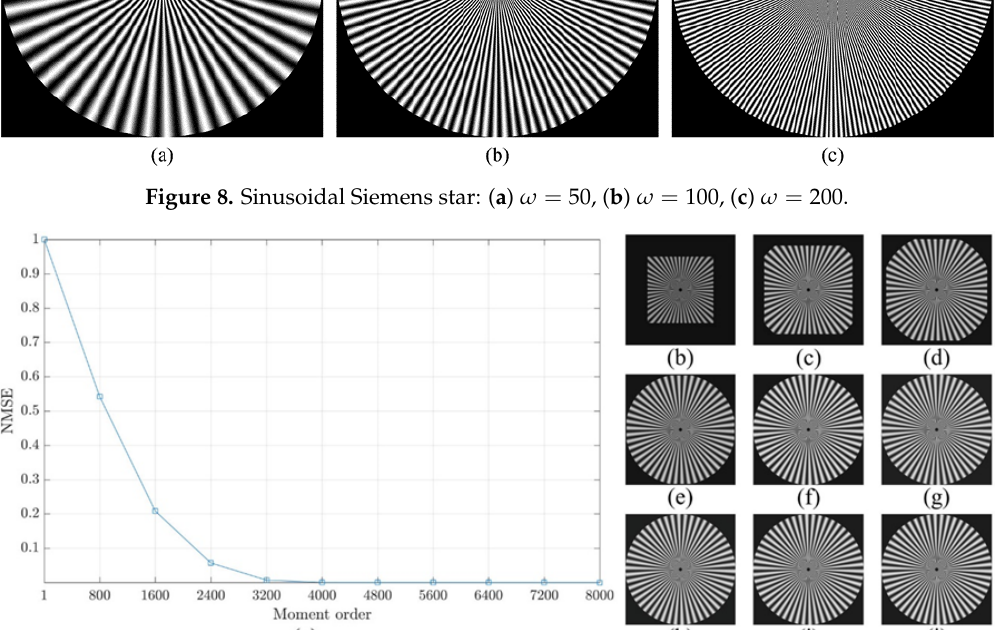
Figure 9. Construction analysis for the proposed method using sinusoidal Siemens start with ω = 50. ( a ) NMSE, image reconstructed using number of moment equal to ( b ) 800, ( c ) 1600, ( d ) 2400, ( e ) 3200,